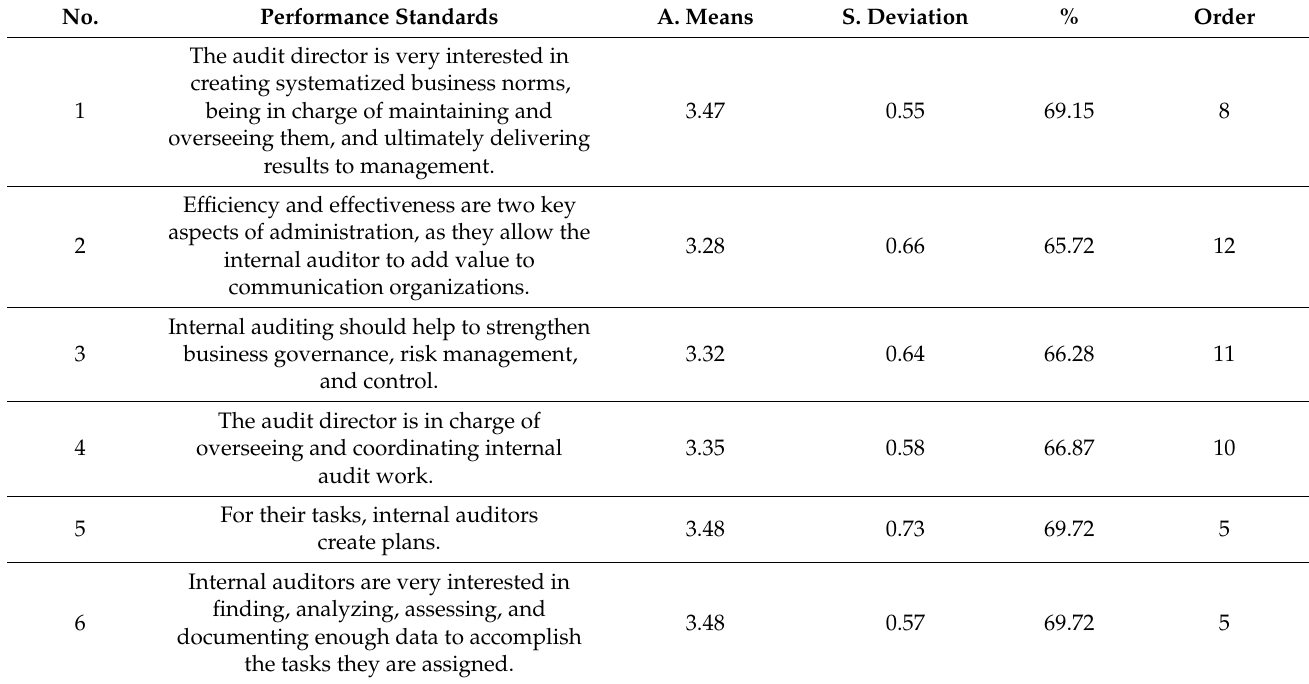
Table 5. The outcomes of Performance